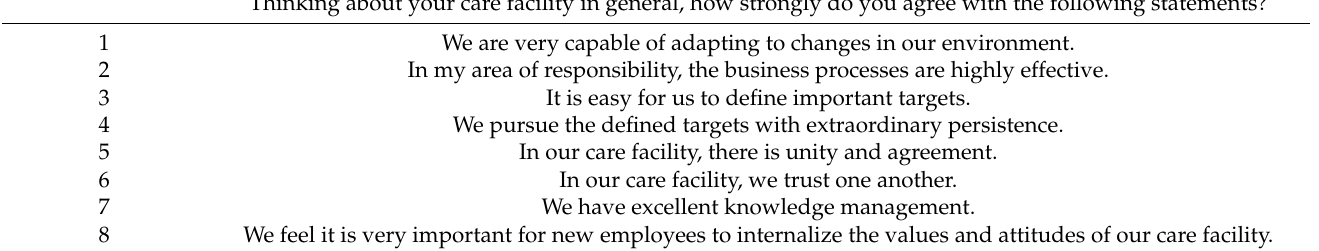
Table 1. Items of the AGIL scale surveyed among leaders of long-term care facilities in Germany during the COVID-19